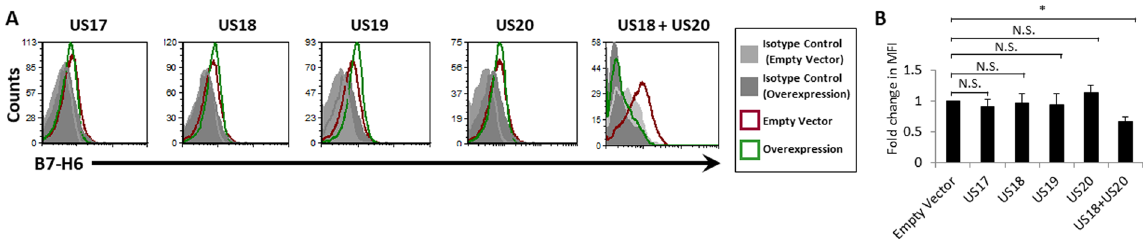
Figure 3. Exogenous overexpression of US18 and US20 is sufficient for reducing B7-H6 surface expression. ( A ) FACS staining for B7-H6 on ARPE19 cells overexpressing HCMV US17, US18, US19 or US20, as presented above the relevant graphs. Histogram colors are as depicted in the figure legend. One representative experiment out of ten is presented. ( B ) Quantification of the results presented in A. Averages of four to ten experiments are presented. Error bars in B represent standard error of the mean. An ANOVA test was performed in order to evaluate significance. * p-value < 0.05. N.S. = non-significant